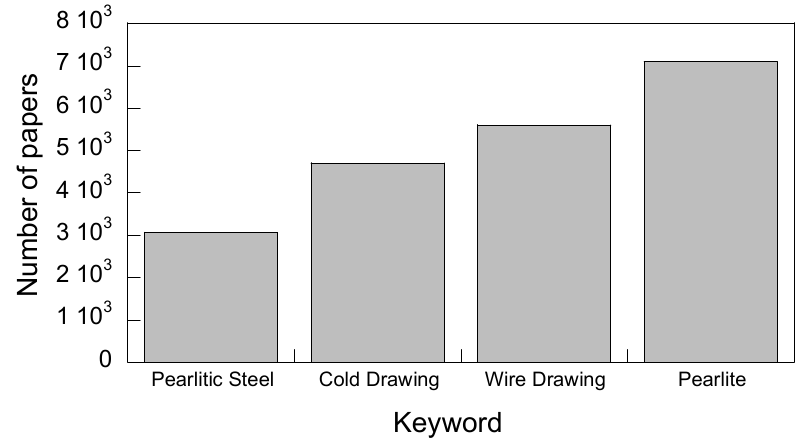
Figure 1. Number of research papers indexed in Scopus related with the following keywords: pearlitic steel, cold drawing, wire drawing, pearlite. (Data collected on February 2016).